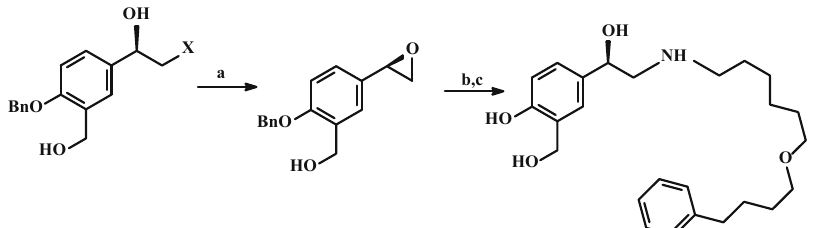
Figure 18: Synthesis of ( R )-( − )- salmeterol. Reaction conditions: ( a ) K 2 CO 3 , THF/MeOH; ( b ) N , O - bis ( trimethylsilyl ) acetamide, DMSO, 3,4 - dimethoxyphenylamine, ( c ) Pd – C/H. Note: Bn = benzyl.